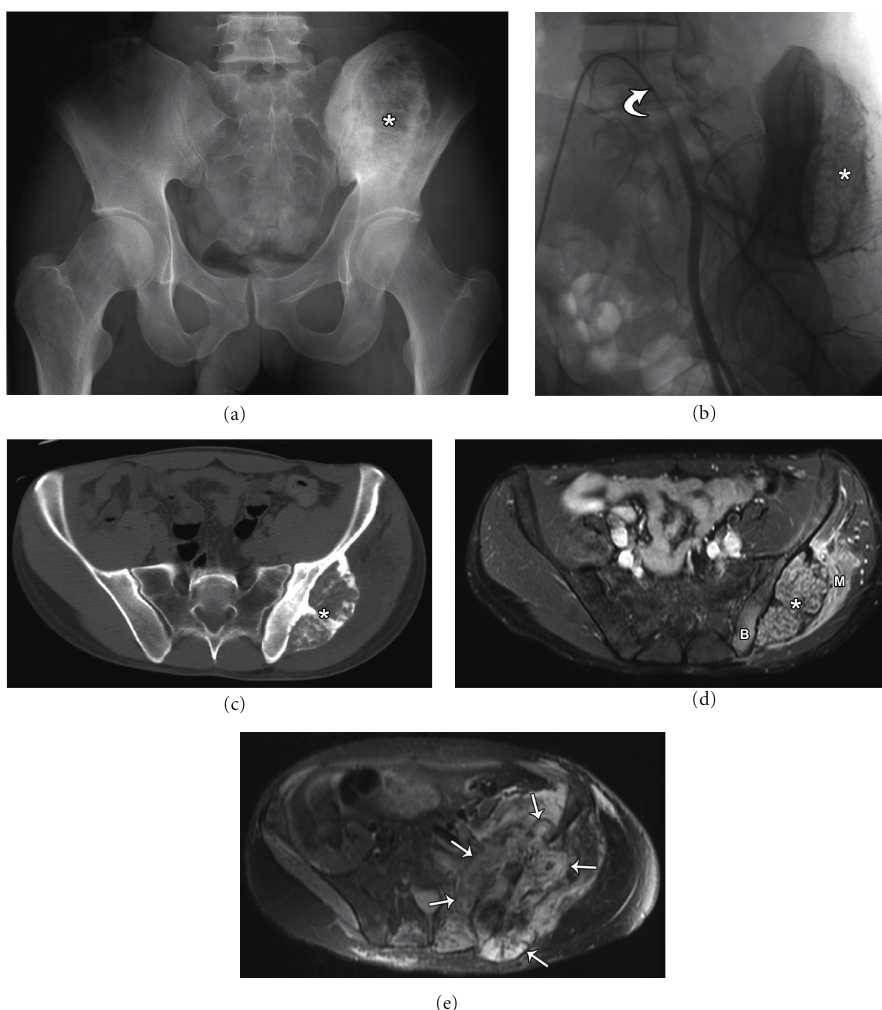
Figure 3: 50-year-old male with osteoblastoma (aka giant osteoid osteoma) involving the left iliac bone. Plain radiograph (a) shows a large lytic left iliac bone lesion (asterisk) with sharp sclerotic borders. An angiographic image (b) with a 5 French cobra catheter (curved arrow) in the left common iliac artery demonstrates the vascular nature of the tumor, with the tumor blush (asterisk) predominantly supplied by the superior gluteal artery which was subsequently embolised a day prior to surgical resection. The axial CT (c) and axial T2 MRI (d) demonstrates the mass originating from the outer cortex of the right iliac bone. It has a narrow zone of transition with distinct borders. Edema is noted in the iliac bone (B) and the gluteal musculature (M) on the fluid sensitive T2 MRI sequence demonstrating the aggressive nature of this benign lesion. Axial T2 MRI (e) 5 years postresection demonstrates unusual progression to high grade osteoblastic osteosarcoma (arrows). Even though benign, osteoblastomas can be locally aggressive, recur or di ff erentiate to a malignant aggressive tumor, in this case necessitating a revision